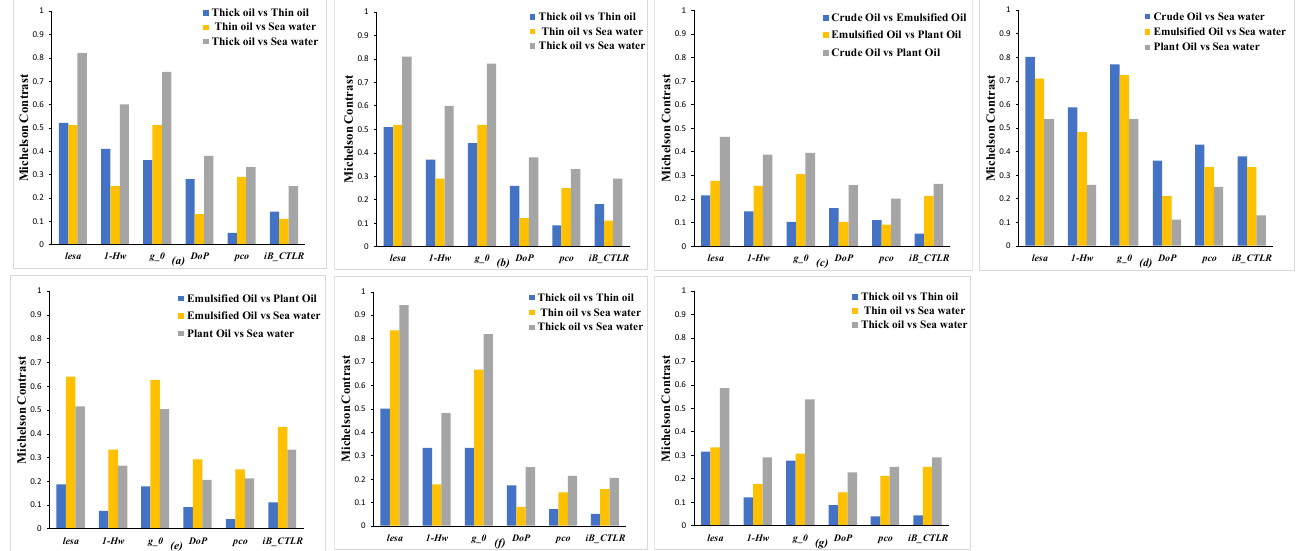
Figure 12. MC measurement results: ( a ) Case 1; ( b ) Case 2; ( c , d ) Case 3; ( e ) Case 4; ( f ) Case 5; ( g ) Case 6.